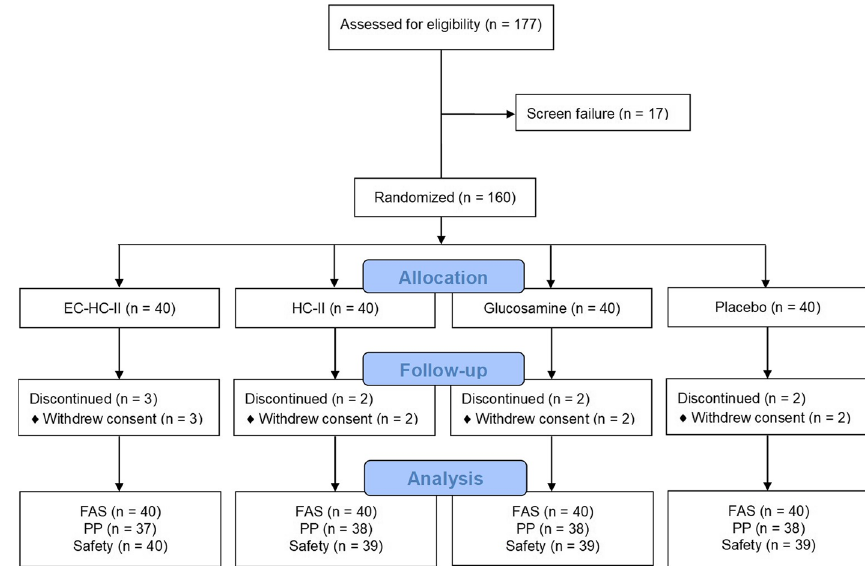
Fig. 1 Diastolic dysfunction among NASH and non-NASH